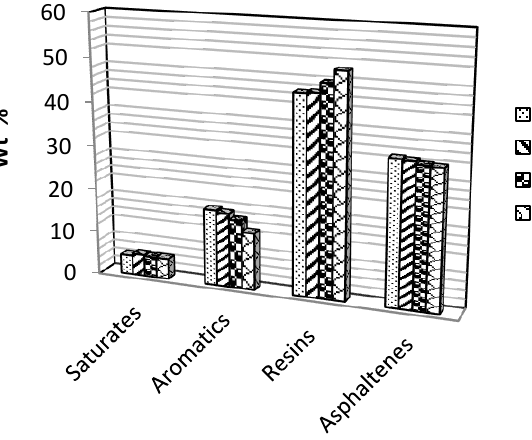
Figure 6. Chemical composition of unfilled and OSP-filled asphalts.